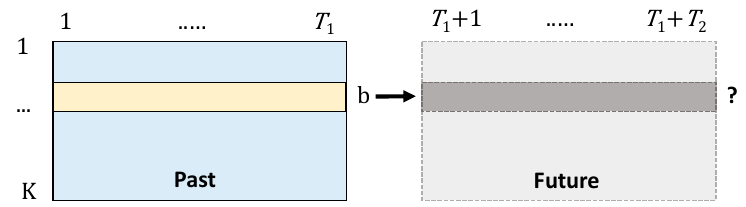
Figure 1. Future performance of the best strategy selected on the basis of past data.